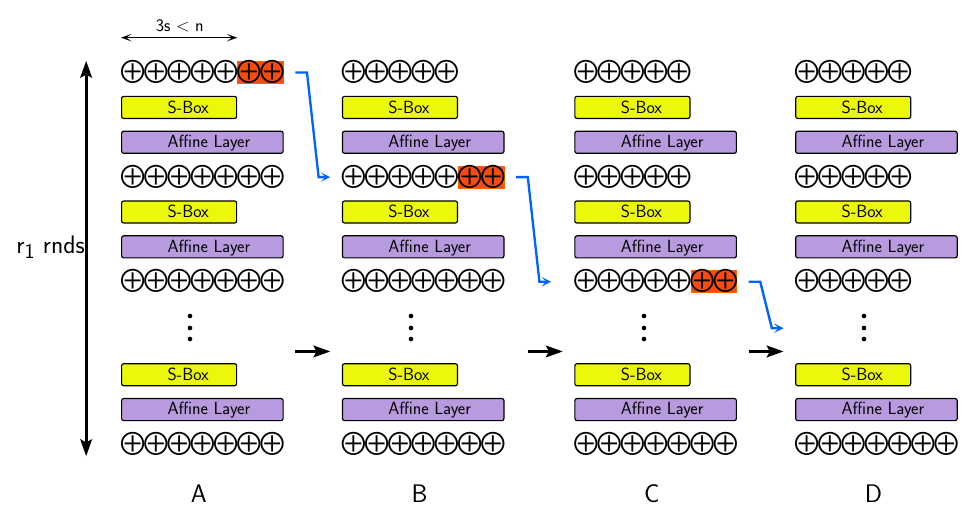
Figure 3: Transforming the round function in the first r 1 rounds. From A → B, the key material not added to bits input to the S-box in round 1 (shown in orange background) are carried to the next round, through the affine layer and merged with the round key in round 2. B → C → D do the same from the second round onwards.